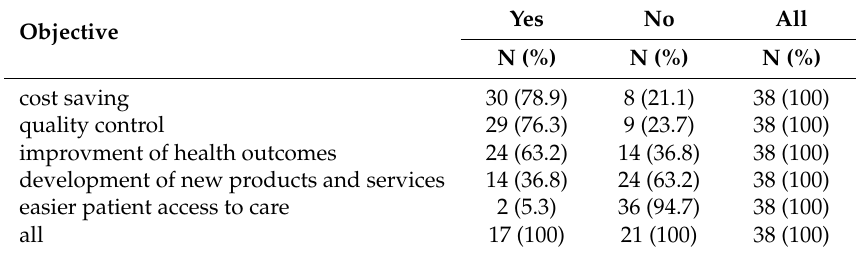
Table 5. What should be the primary measurable objectives of an e-health system? (you can answer more than